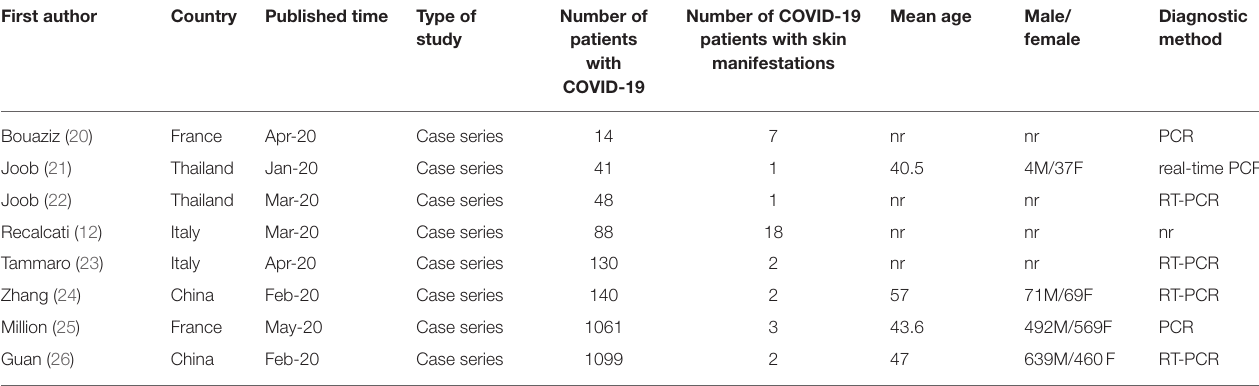
TABLE 1 | Characteristics of included prevalence